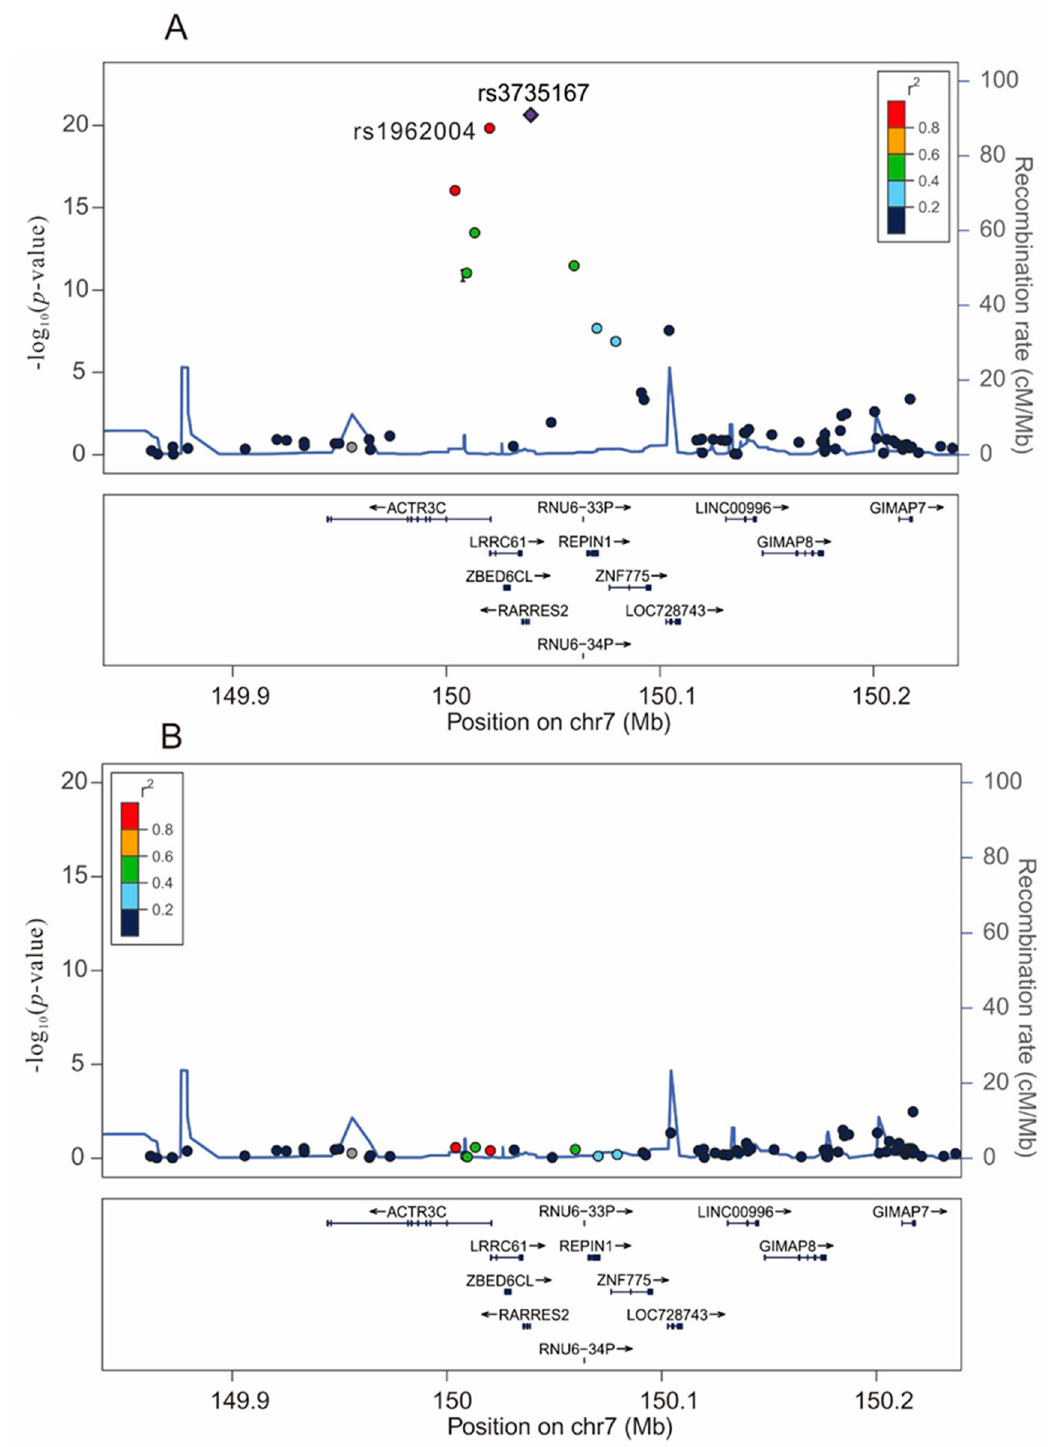
Figure 1. Regional association plots at a region of 100 kb surrounding the RARRES2 locus on chromosome 7. Regional association plots for the top-hit of association with chemerin levels at a region of 100 kb surrounding the RARRES2 locus on chromosome 7, without ( A ) or with ( B ) conditional analysis with adjustment of the rs3735167 polymorphism.